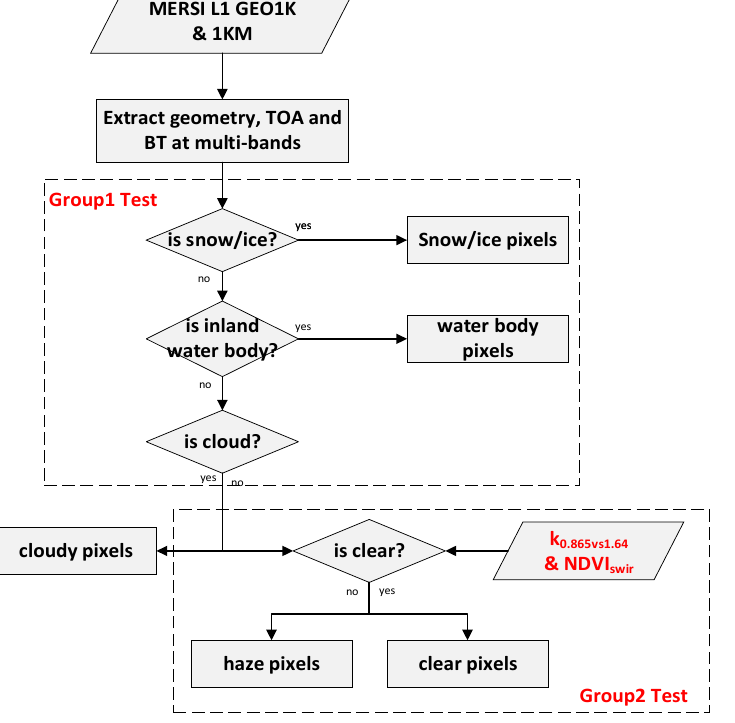
Figure 2. Flowchart of the MHAM algorithm using FY3D/MERSI-II observations. Firstly, the DN (data number) values at different bands were extracted from the MERSI- II L1 data and converted to the apparent reflectance of the top of the atmosphere (TOA) at visible wavelengths or the brightness temperature at the infrared bands. The geolocation information and observed angles were extracted from the dataset. It must be noted that the MERSI Level 1 data at 1 km instead of those at 250 m were used in this analysis. Secondly, the ice/snow pixels were filtered out using the normalized difference snow index (NDSI), which was calculated using the apparent reflectance values at 0.55 µ m (R 0.55 ) and 1.64 µ m (R 1.64 ) for Landsat or R 0.55 and R 2.12 for MYD35 or R 0.865 and R 1.24 for MXD04 DT. Here, the ratio of the difference between R 0.55 and R 1.64 to the sum of R 0.55 and R 1.64 was taken as the NDSI. When both NDSI > 0.4 and R 0.865 > 0.1 were true, the pixel